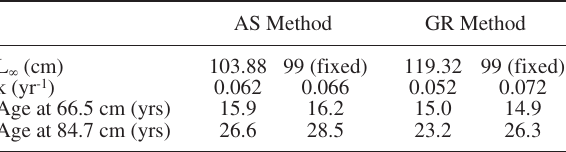
Table 1. – Von Bertalanffy growth function (VBGF) parameters k (growth coefficient) and L (mean asymptotic carapace length) re- ∞ sulting from the growth rate (GR) and the age at size (AS) methods and the ages calculated from these VBGFs for the range of mean curved carapace lengths (CCL) of Mediterranean nesting females (Margaritoulis et al ., 2003). Values are also provided for L fixed at ∞ the maximum CCL recorded in the